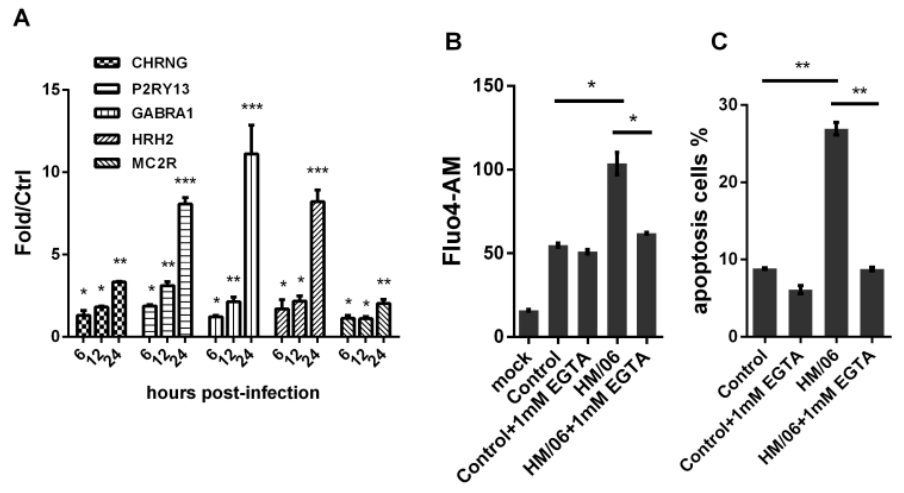
Figure 10. H5N1 infection elevated internal Ca 2+ and EGTA treatment decreased virus-induced apoptosis. ( A ) H5N1 infection upregulated several genes functioned as receptor for neurotransmitters via qRT-PCR test; ( B ) H5N1-infected cells were treated with control or 1 mM EGTA for 24 h. 5 μM Fluo4-AM in HBSS was added for 30 min, and then Fluo4-AM fluorescence was tested by BD FACSCalibur system; ( C ) Apoptosis of control or EGTA treated infected-cells was analyzed using FITC-annexin V Apoptosis